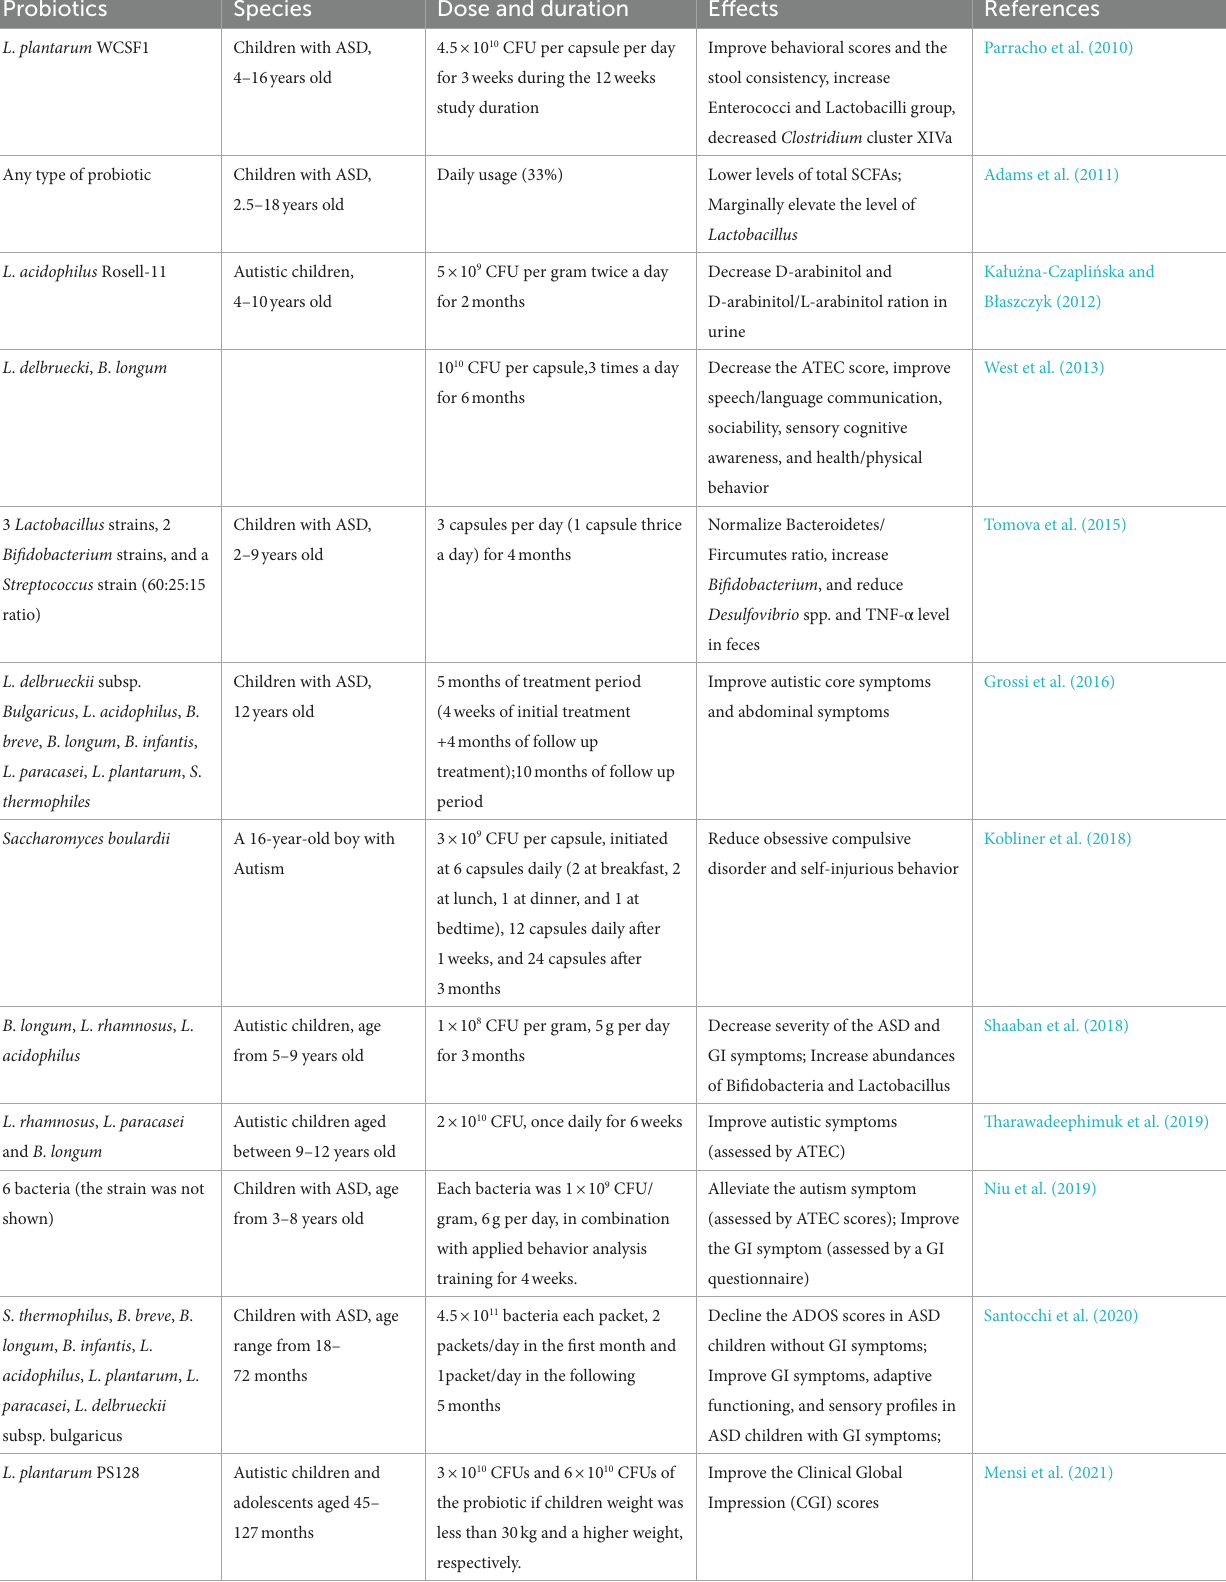
TABLE 1 Effect of probiotic supplementation on the health status of individuals with ASD.